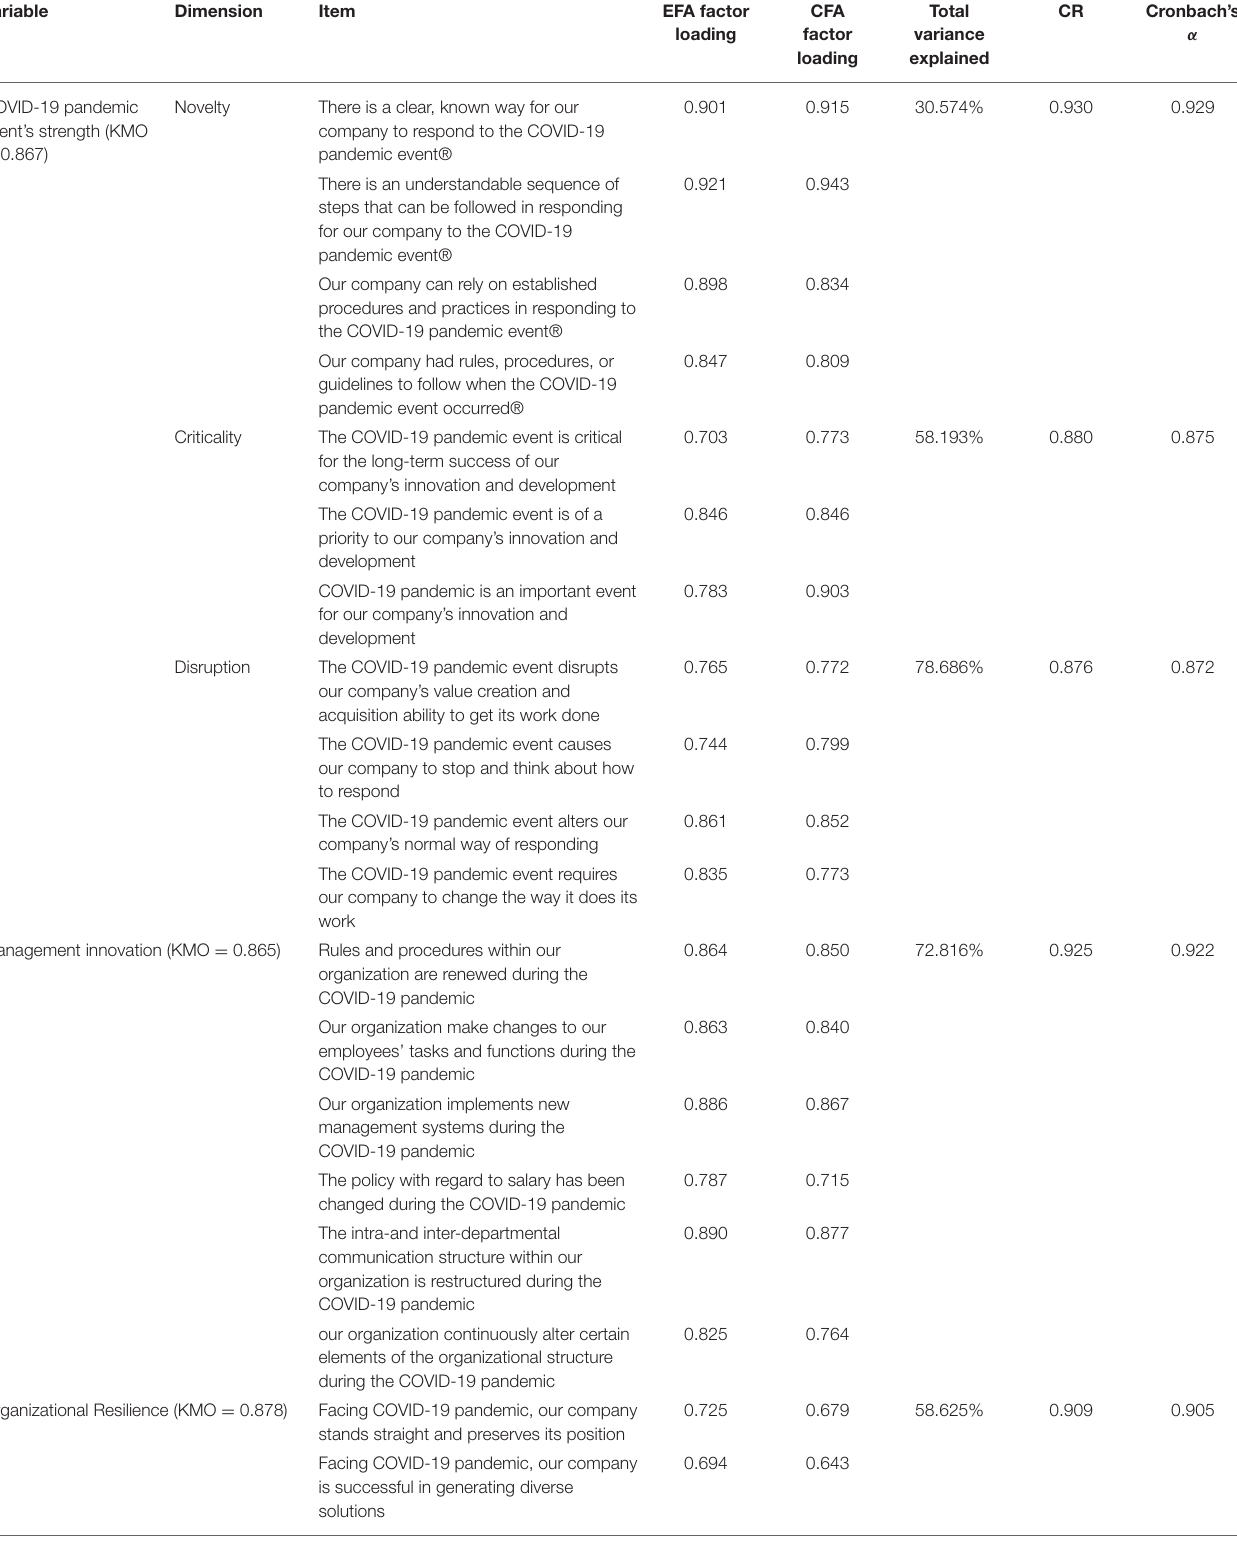
CFA Total CR Cronbach’s α loading factor variance loading explained